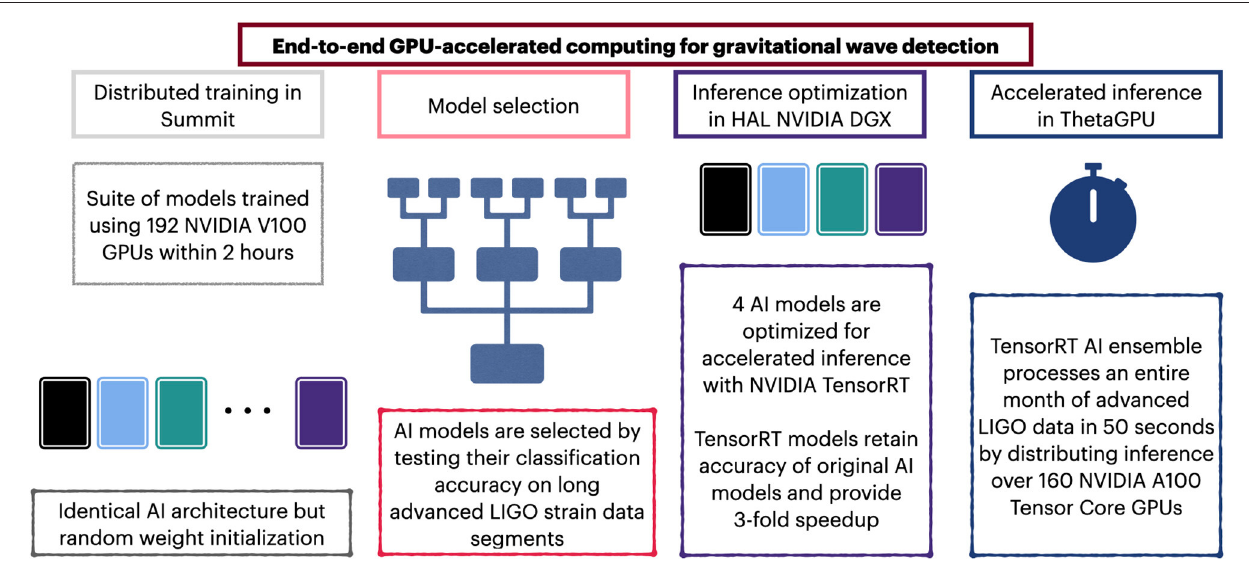
FIGURE 8 | Convergence of AI and HPC. Schematic representation of our methodology to harness disparate HPC platforms and data science tools to create optimal AI ensembles for gravitational wave